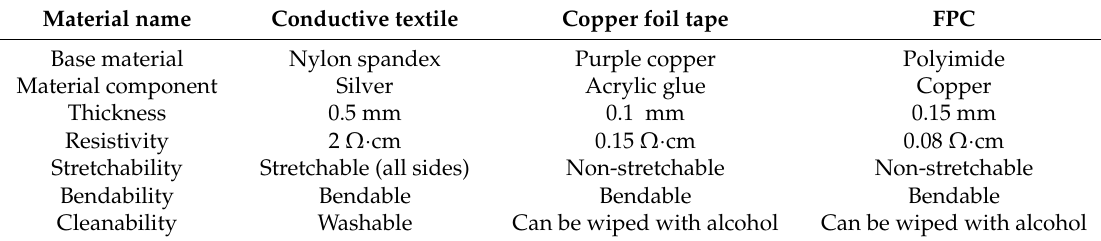
Table 1. Characteristics of three